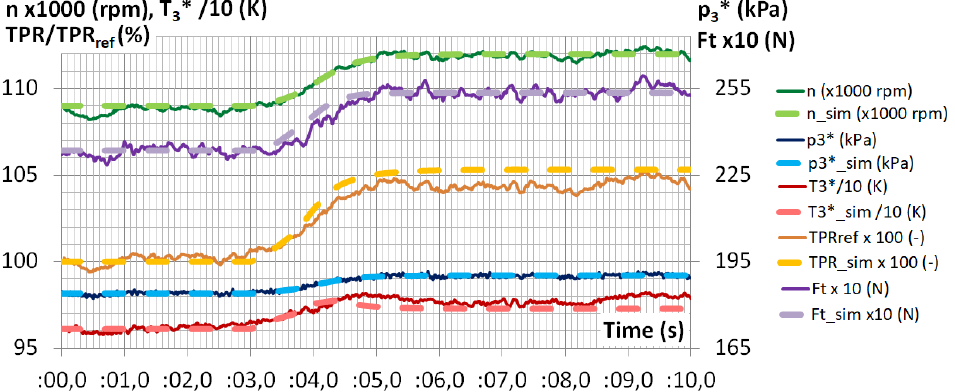
Figure 7. Comparison of values obtained from measurement (solid) and simulation (dashed)